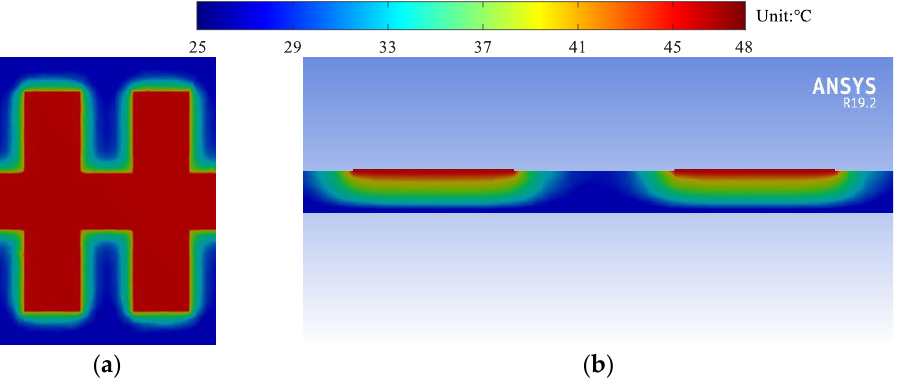
Figure 13. Simulated thermal profile of the H-shaped corrugated SWTL: ( a ) top view; ( b ) cross- sectional view.